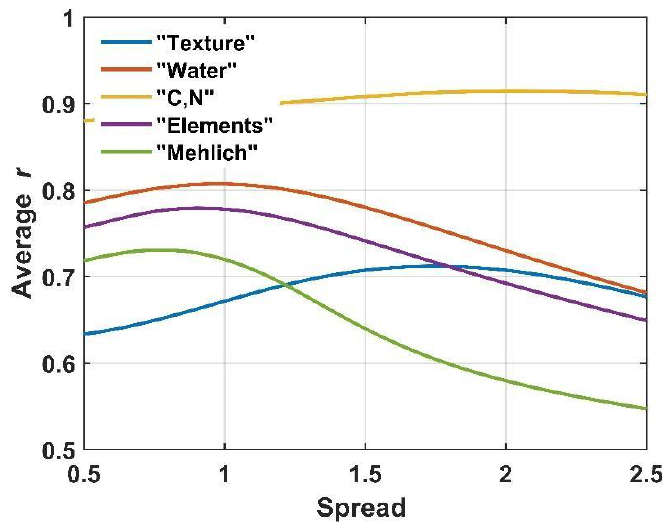
Figure 3. Dependence of the linear correlation coefficient between the reference and modeled values as a function of the spread value. as a function of the spread